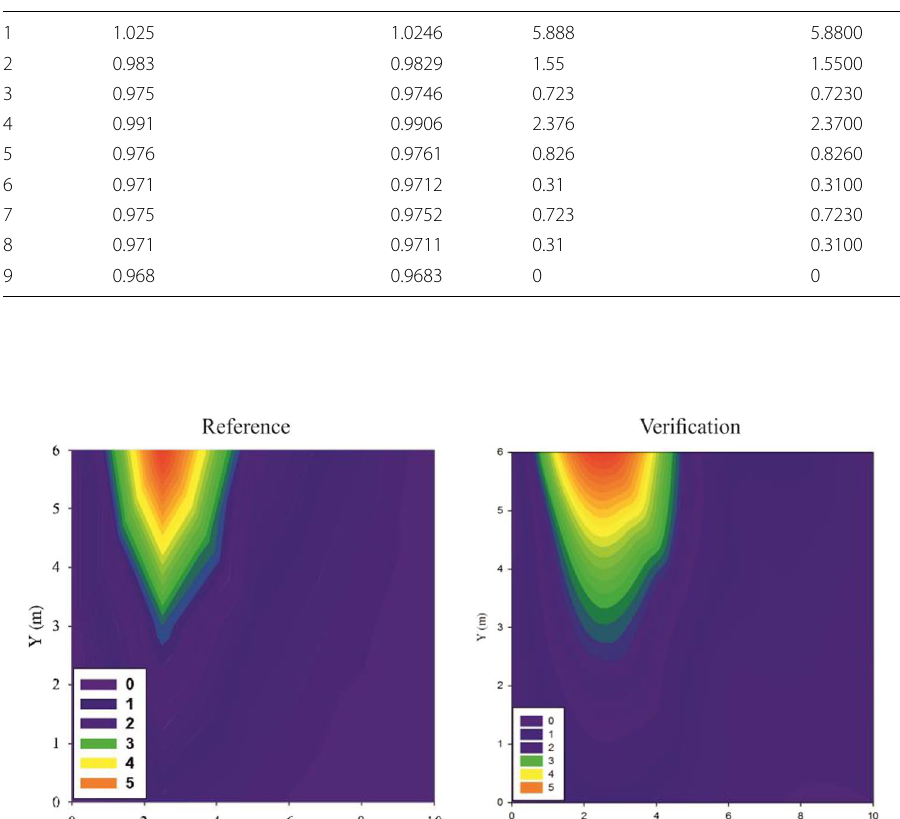
Table 2 Comparison of verification results from modeling and the reference paper Sensor RDI NDI Reference (Ahmadnejad Calculated Reference (Ahmadnejad Zarnaghi and Tarighat 2018) Zarnaghi and Tarighat 2018)